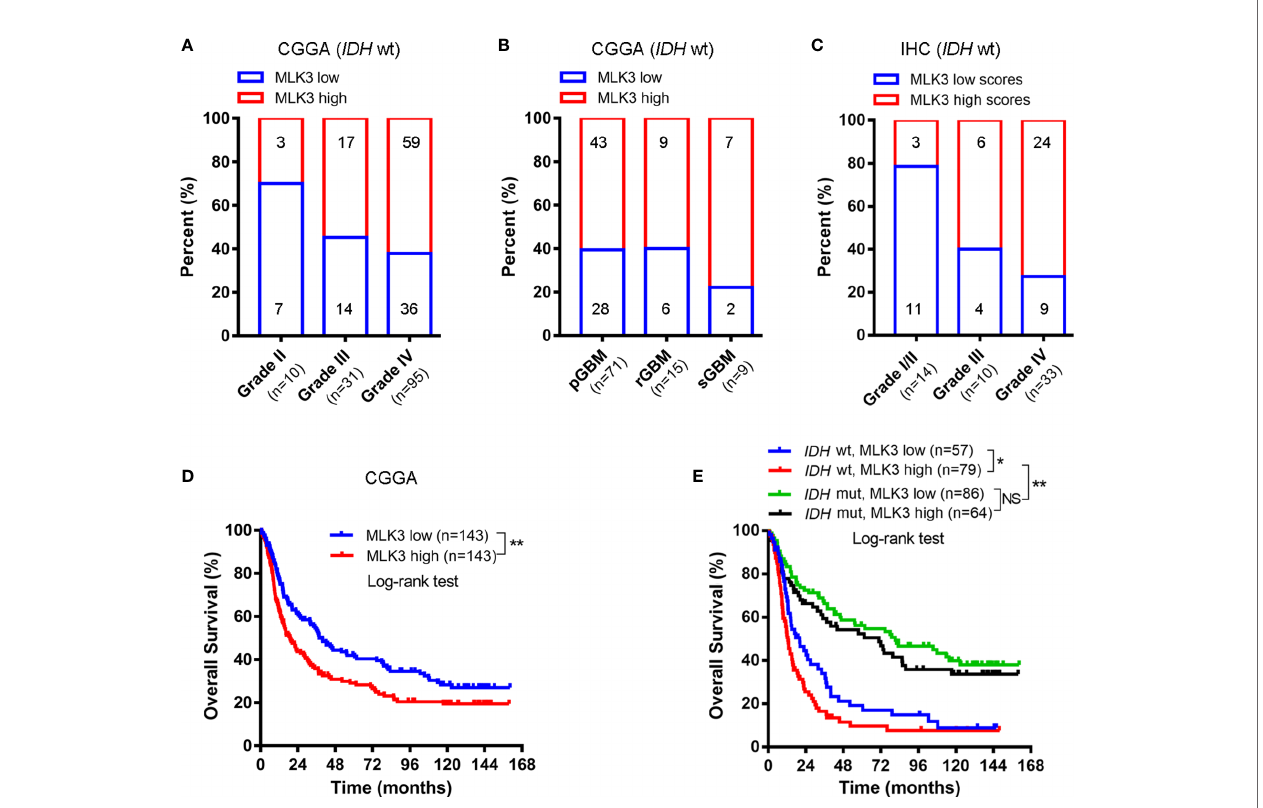
FIGURE 2 | High MLK3 levels are correlated with poor prognosis in patients with IDH -wt GBM. (A, B) High levels of MLK3 mRNA are prevalent in IDH -wt GBM. The frequencies of high MLK3 mRNA levels in IDH -wt gliomas (n = 136), primary GBM (n = 71), recurrent GBM (n = 15), and secondary GBM (n = 9) were analyzed. The data were derived from the CGGA dataset. The median level of MLK3 mRNA in glioma samples was chosen as the cut-off point. pGBM, primary GBM; rGBM, recurrent GBM; sGBM, secondary GBM. (C) MLK3 abundantly expressed in IDH -wt GBM. The percent of high MLK3 protein levels in IDH -wt gliomas (n = 57) was investigated. The data were obtained from IHC analysis. (D, E) High levels of MLK3 mRNA are associated with the poor prognosis of patients. Kaplan-Meier survival analyses for MLK3 mRNA expression (n = 286) (D) and MLK3 mRNA expression and IDH gene status (n = 286) (E) . The data were derived from the CGGA dataset. Log-rank test. NS, not signi fi cant. * P < 0.05, ** P <